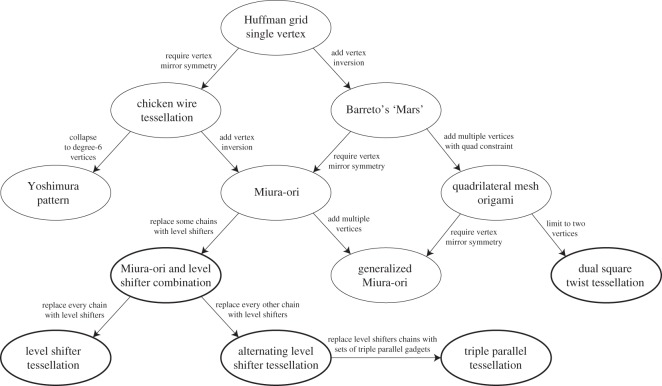
Rigidly foldable tessellations. New tessellations introduced in this paper are shown with a bold outline.